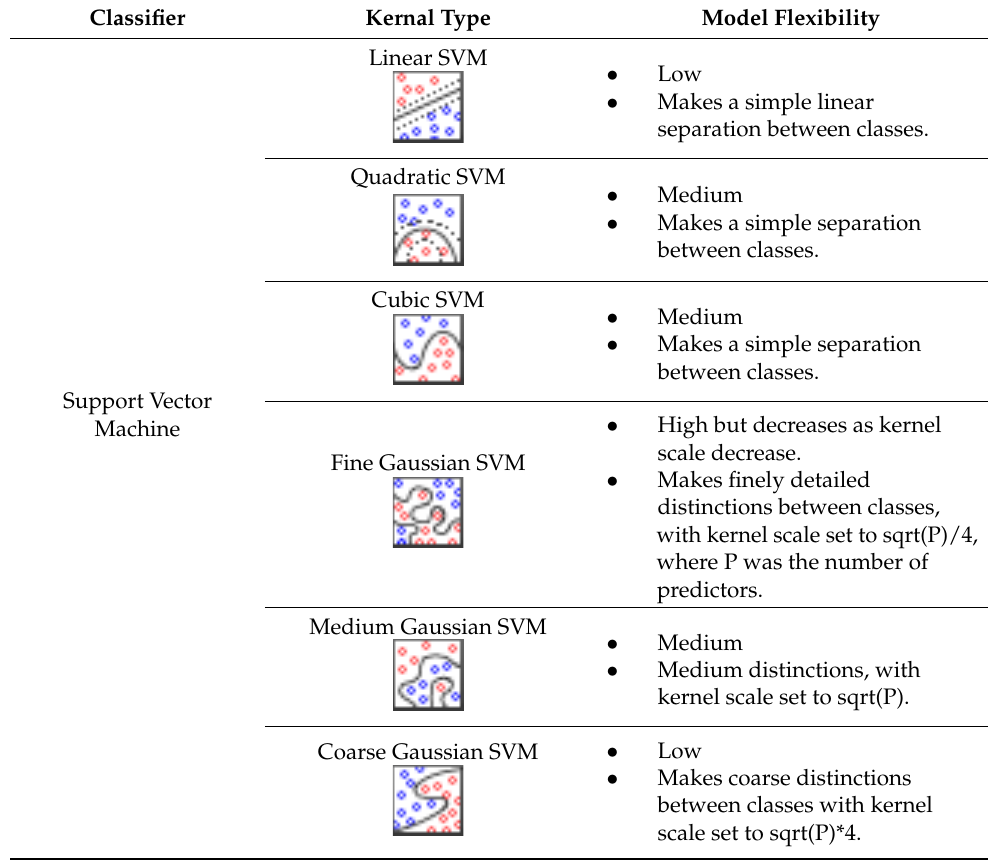
Table 1. List of classifiers with its corresponding type and model flexibility [53].